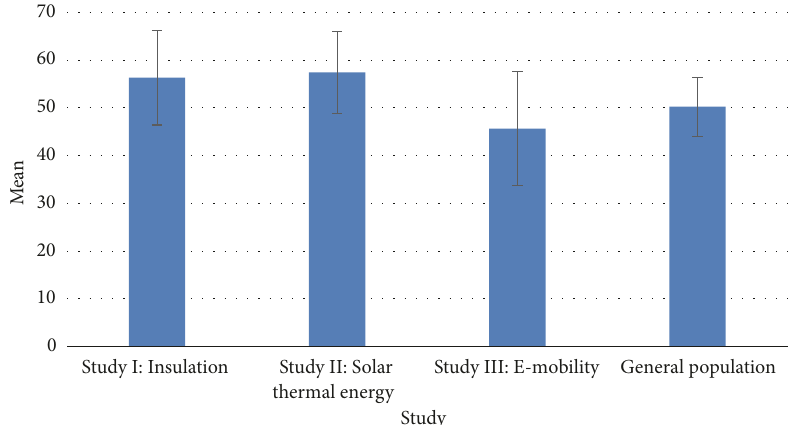
Figure 1: Age distributions (means and standard deviations) of the samples in comparison to the basic population of German adults.